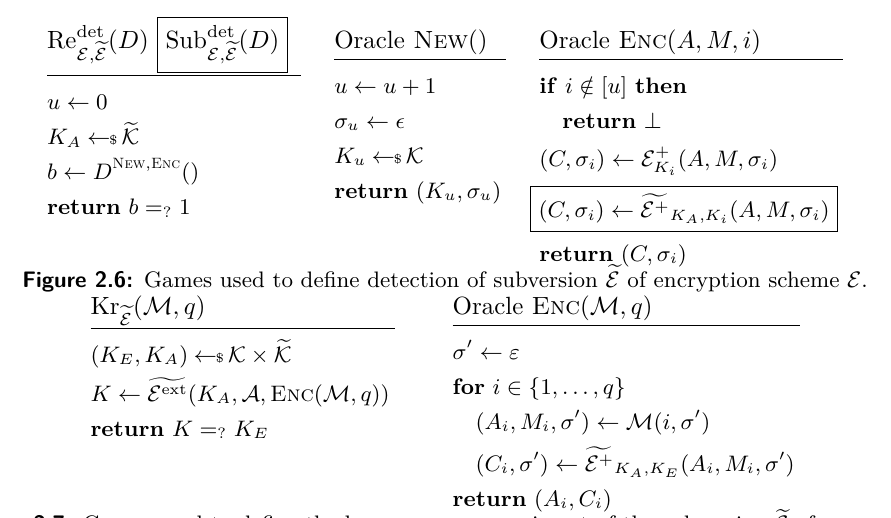
Figure 2.6: Games used to define detection of subversion e E of encryption scheme E .